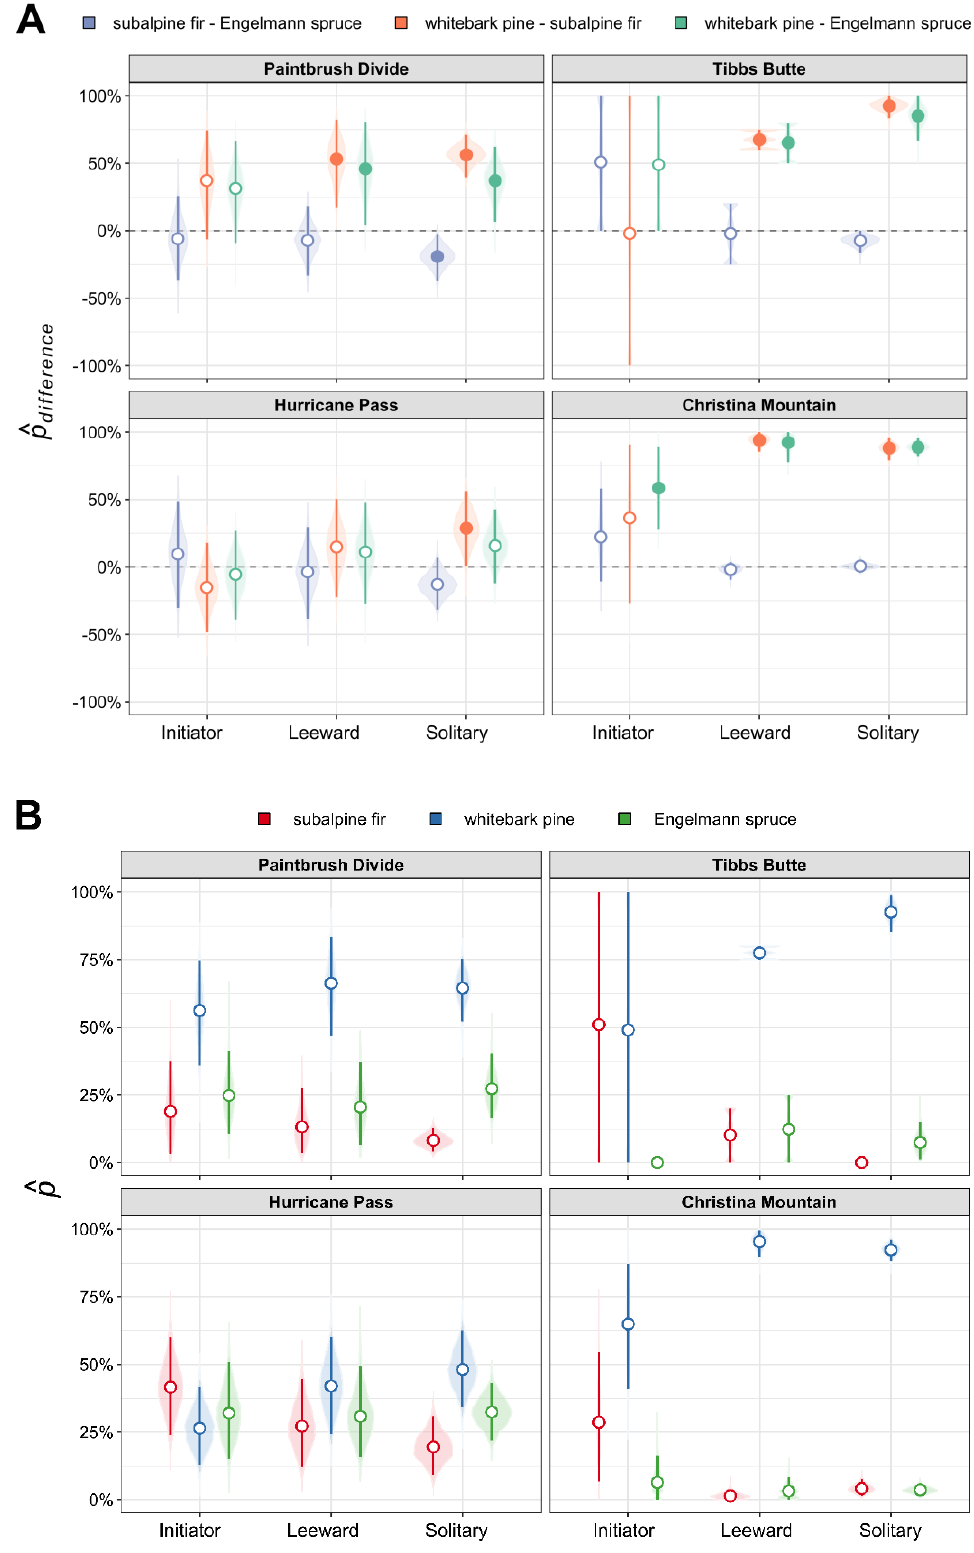
Figure 4. Parameter estimates for community composition by ecological role. ( A ) Pairwise mean differences in relative abundance among species, by ecological role. ( B ) Conifer species relative abundance by ecological role. Shaded centers delineate sampling distributions, circles indicate parameter estimates, and vertical lines delineate 98.3% CIs ( A ) or 95% CIs ( B ). Closed circles in ( A ) denote significant differences.